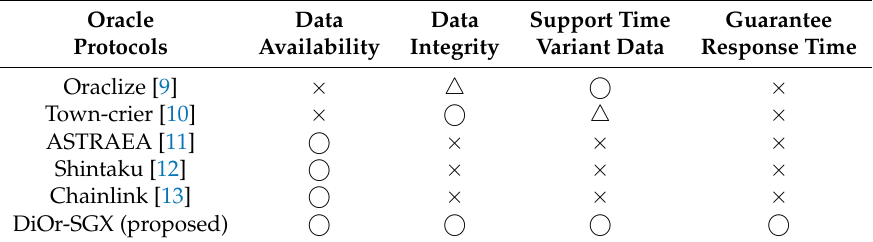
Table 1. Summary of Comparison for Oracle